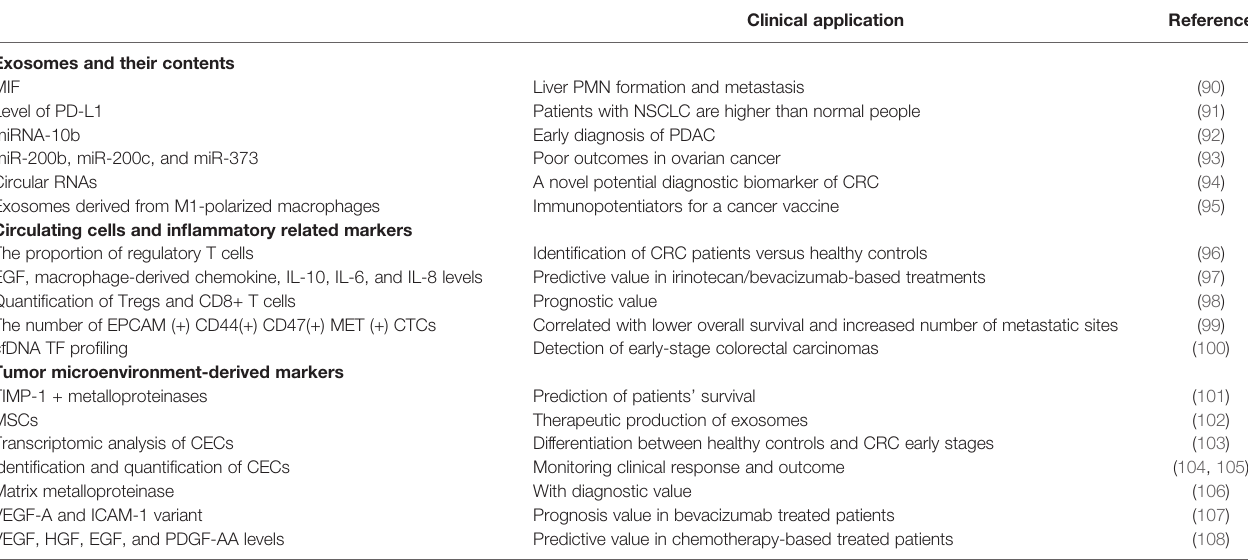
TABLE 1 | Clinical application of liquid